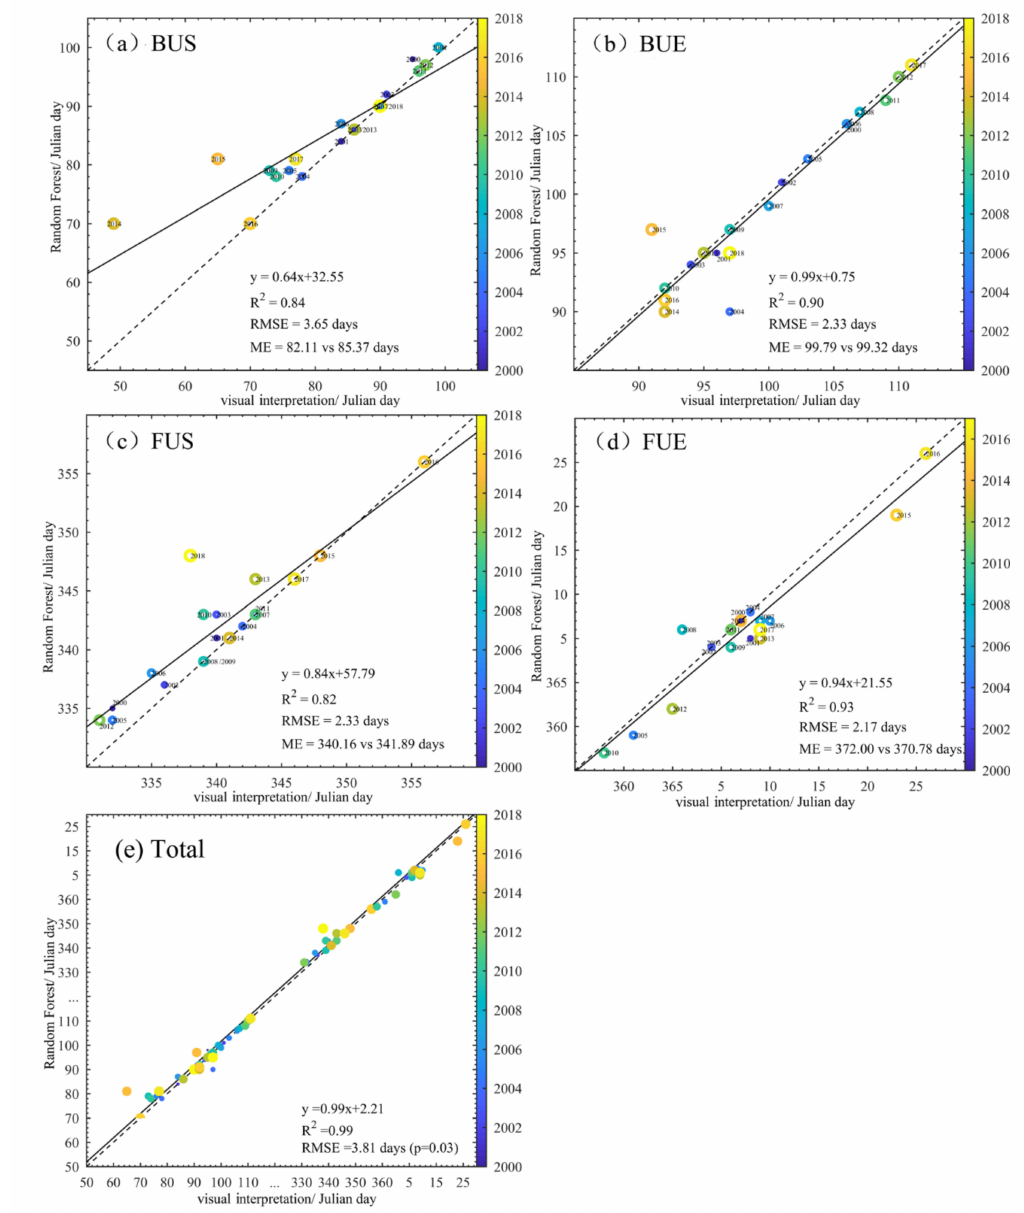
Figure 8. The Julian day comparison between RF and visual interpretation (color and circle size represents the year. ( a ). BUS; ( b ). BUE; ( c ). FUS; ( d ). FUE; ( e ). Total